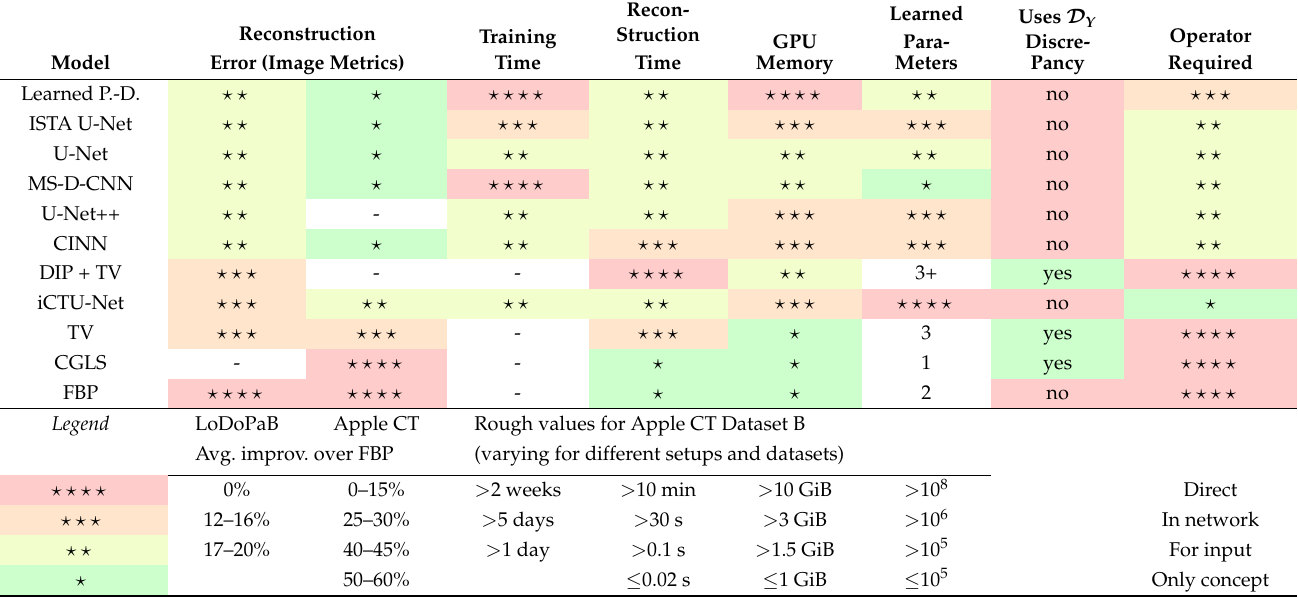
Table 6. Summary of selected reconstruction method features. The reconstruction error ratings reflect the average per- formance improvement in terms of the evaluated metrics PSNR and SSIM compared to filtered back-projection (FBP). Specifically, for LoDoPaB-CT improvement quotients are calculated for PSNR and SSIM, and the two are averaged; for the Apple CT experiments the quotients are determined by first averaging PSNR and SSIM values within each noise setting over the four angular sampling cases, next computing improvement quotients independently for all three noise settings and for PSNR and SSIM, and finally averaging over these six quotients. GPU memory values are compared for 1-sample batches.